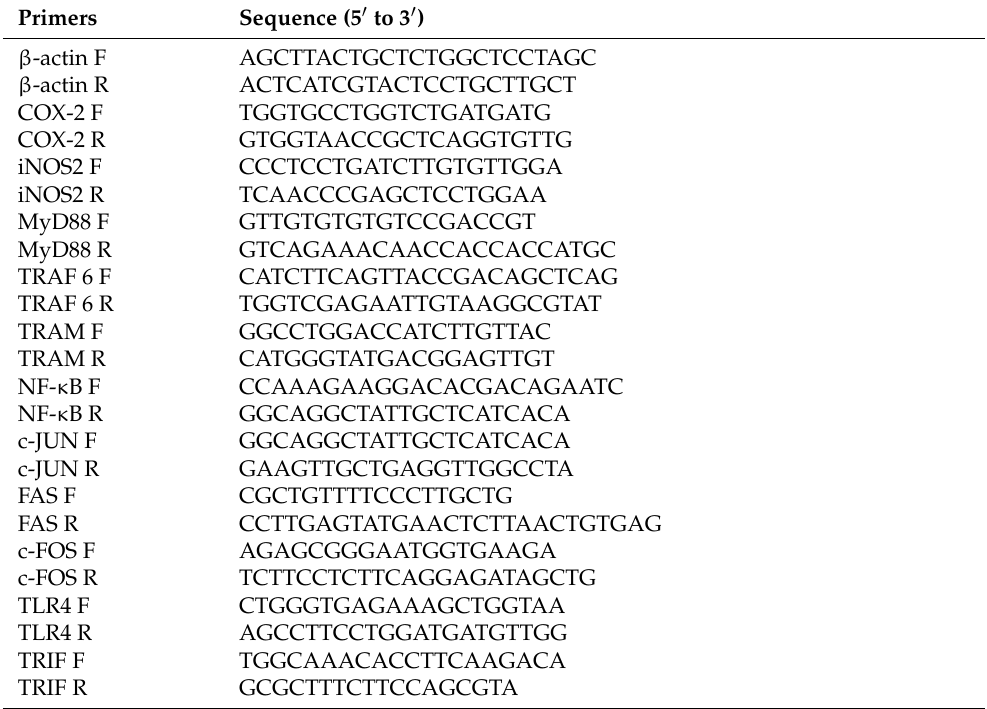
Table 1. Sequence of primers used for